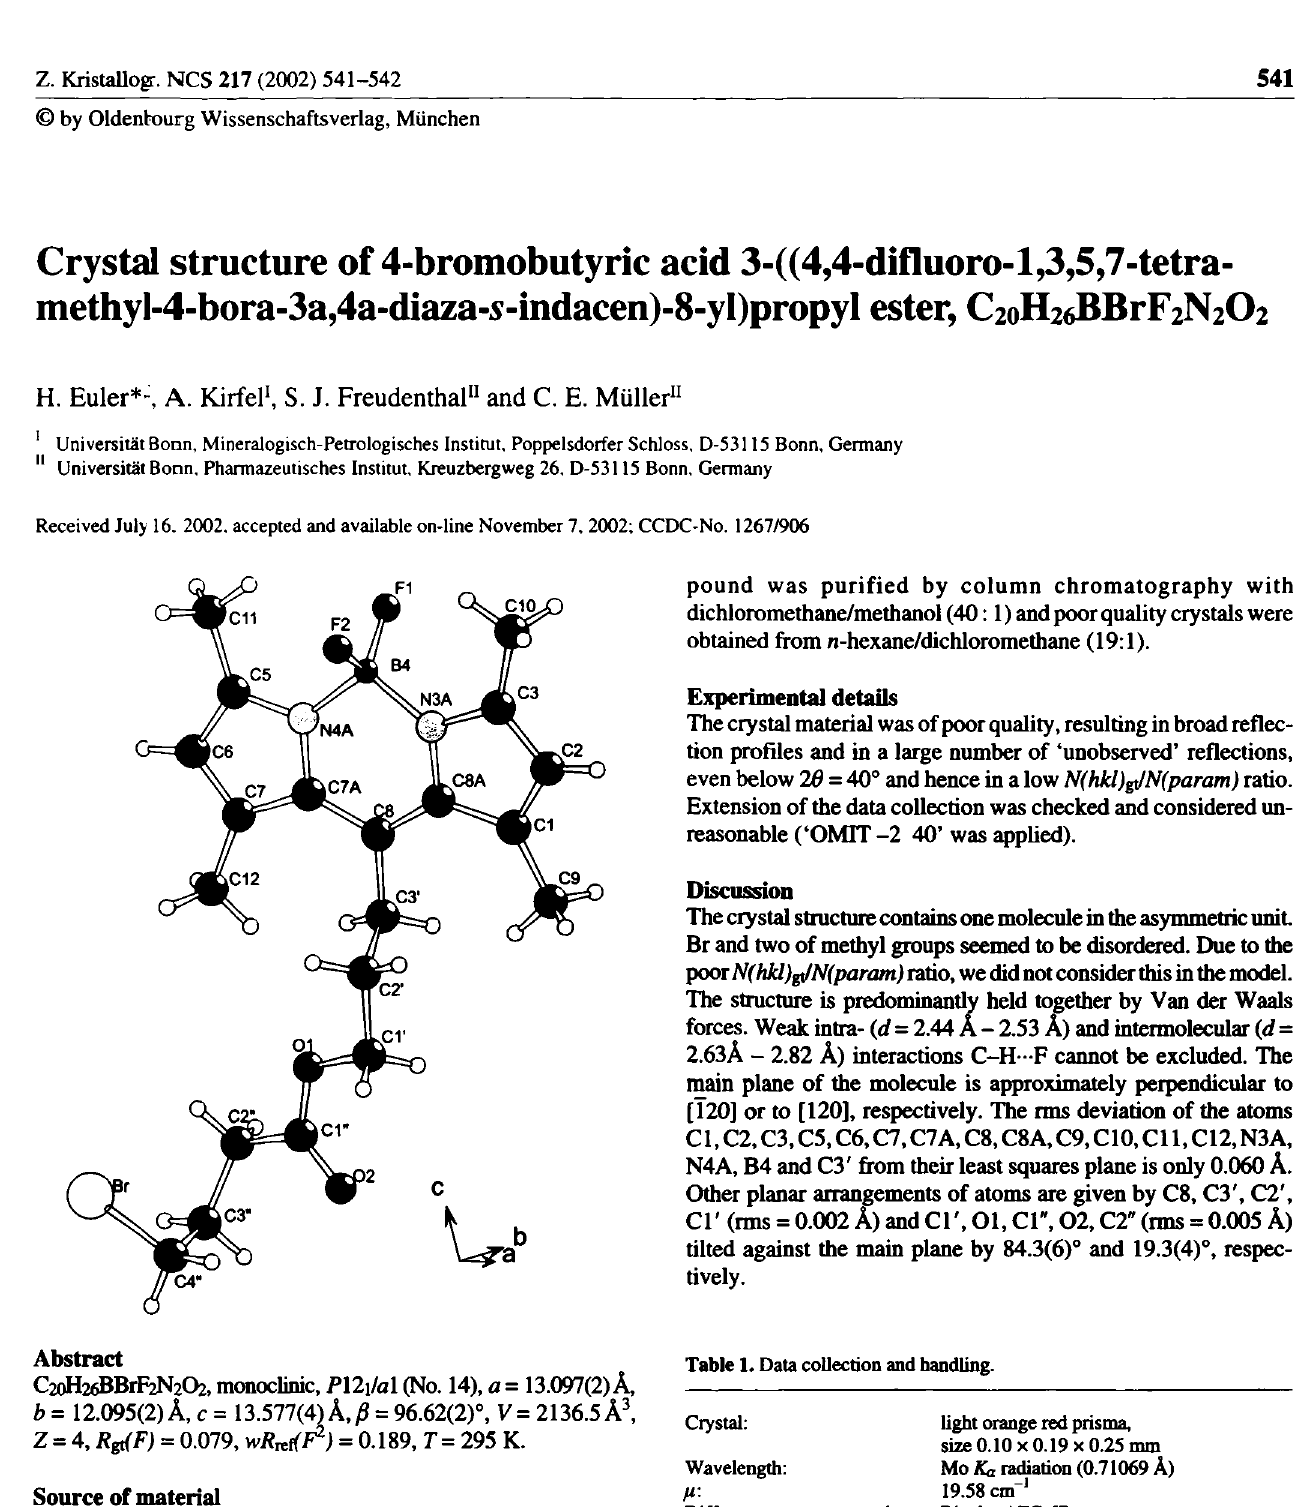
Table 1. Data collection and handling.